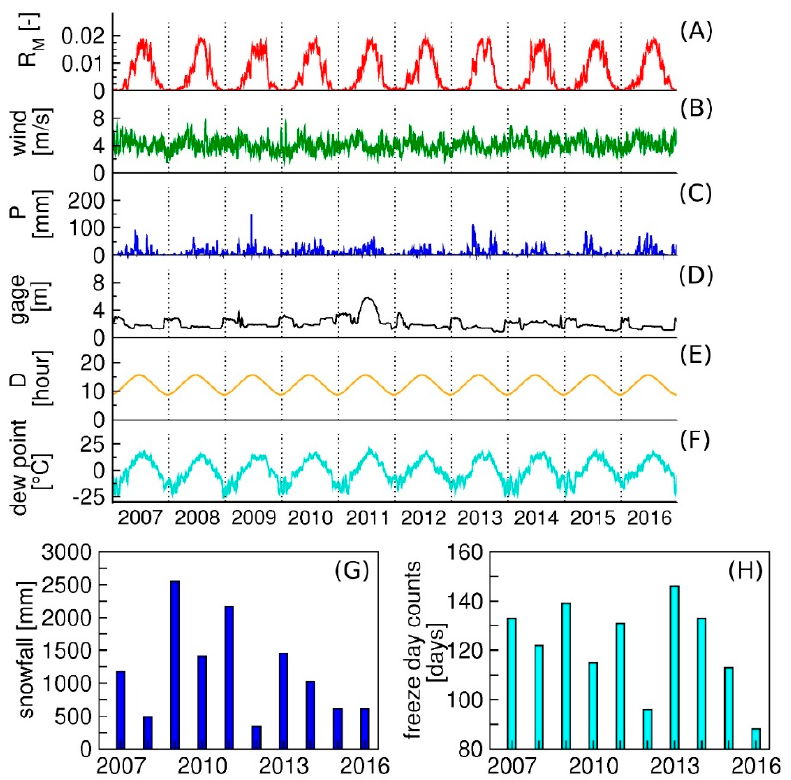
Figure 4. Time series for the ecological factors tested to predict mosquito numbers between 2007 and 2016. Panel ( A ) shows reproduction rate of mosquitoes ( R M ); Panel ( B ) wind velocity; Panel ( C ) precipitation ( P ); Panel ( D ) gage height of Missouri river; Panel ( E ) day length ( D ); Panel ( F ) dew point; Panel ( G ) snowfall; and Panel ( H ) the numbers of freeze days. Variables shown in panels ( A – F ) are described on a weekly basis. Variables in panel ( G – H ) have a yearly basis.